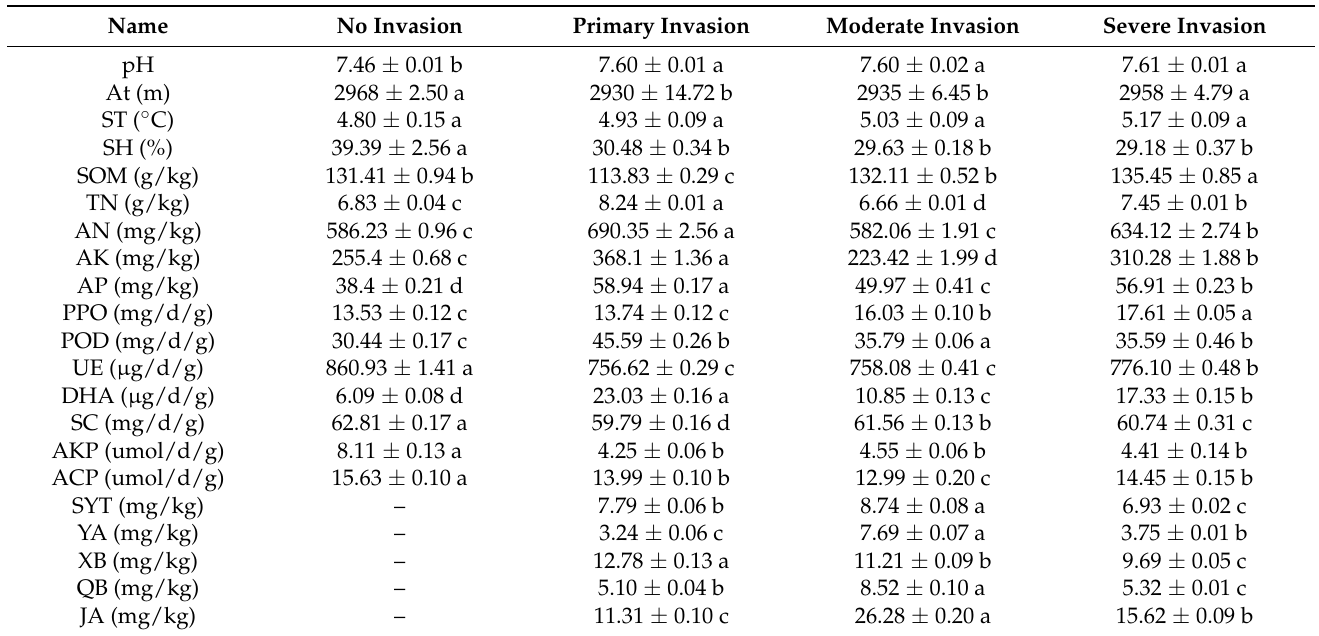
Table 2. Statistical table of physical and chemical properties, enzyme activities, and allelochemicals in rhizosphere